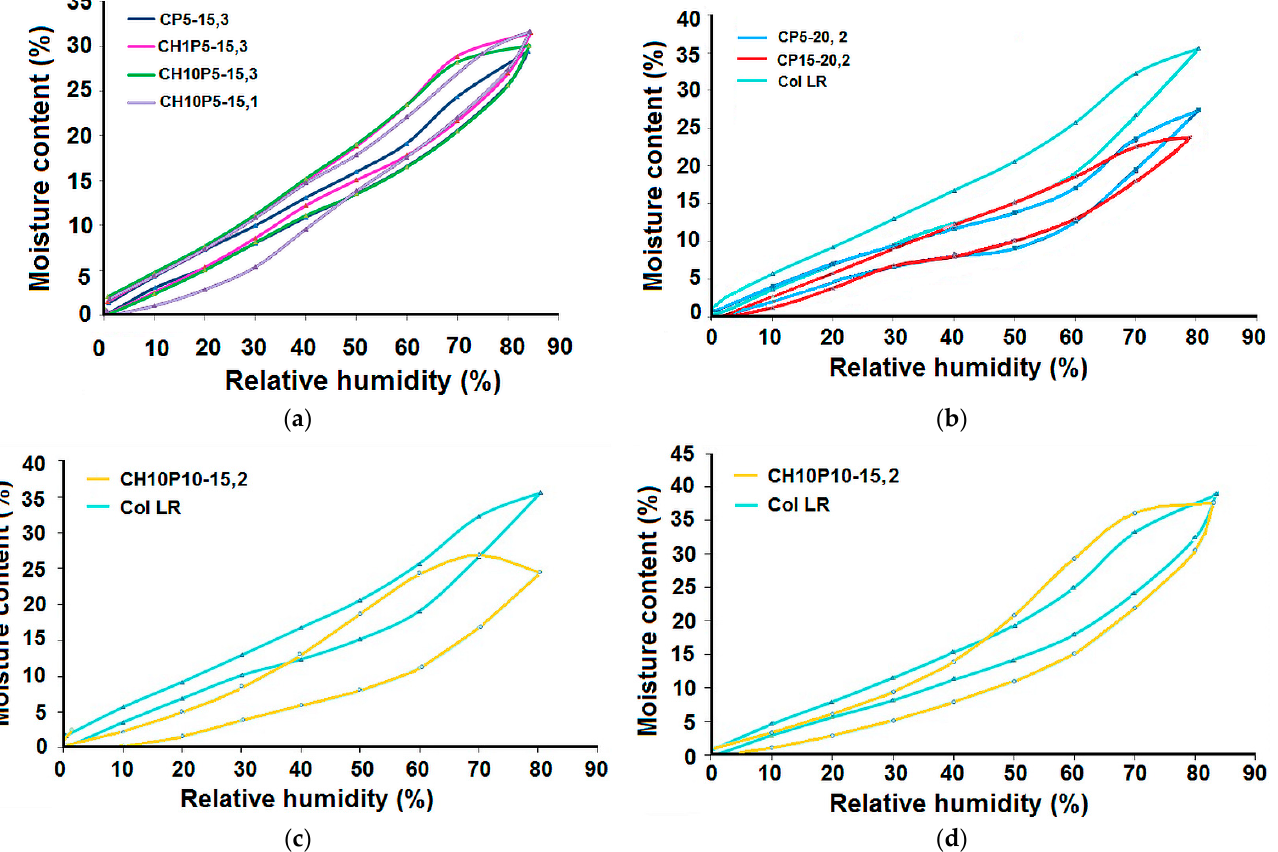
Figure 3. Typical water vapour sorption–desorption isotherms: effect of composition. Registration conditions: ( a , b ) and ( c ) equilibrium time 10/20 min; ( d ) equilibrium time 40/60 min.